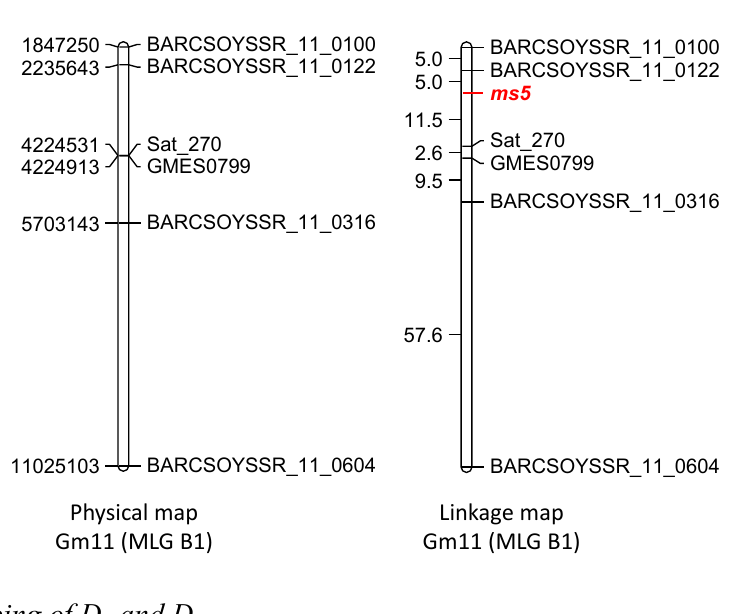
Figure 2. Genetic linkage mapping of the ms5 gene from the cross Manchu (PI 30593) × T277H; Ms5ms5 . Genetic and physical maps of soybean chromosome Gm11 (MLG B1) showing location of the ms5 locus. Genetic distances are shown in centiMorgans (cM) and physical distances are shown in base pairs